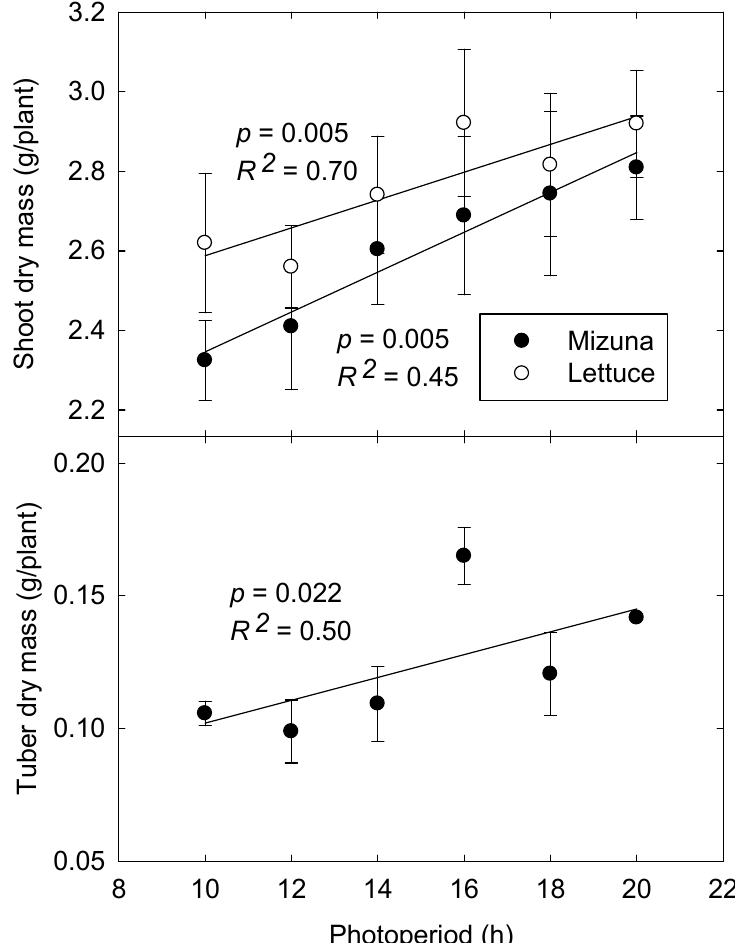
Figure 6. Aboveground biomass of lettuce and mizuna ( top ) and tuber biomass of mizuna ( bottom , data from 2nd study only) grown under different photoperiods and photosynthetic photon flux densities with the same daily light integral of 16 mol·m − 2 ·d − 1 . Error bars represent SE (shoot dry mass: n = 6; tuber dry mass: n = 3).